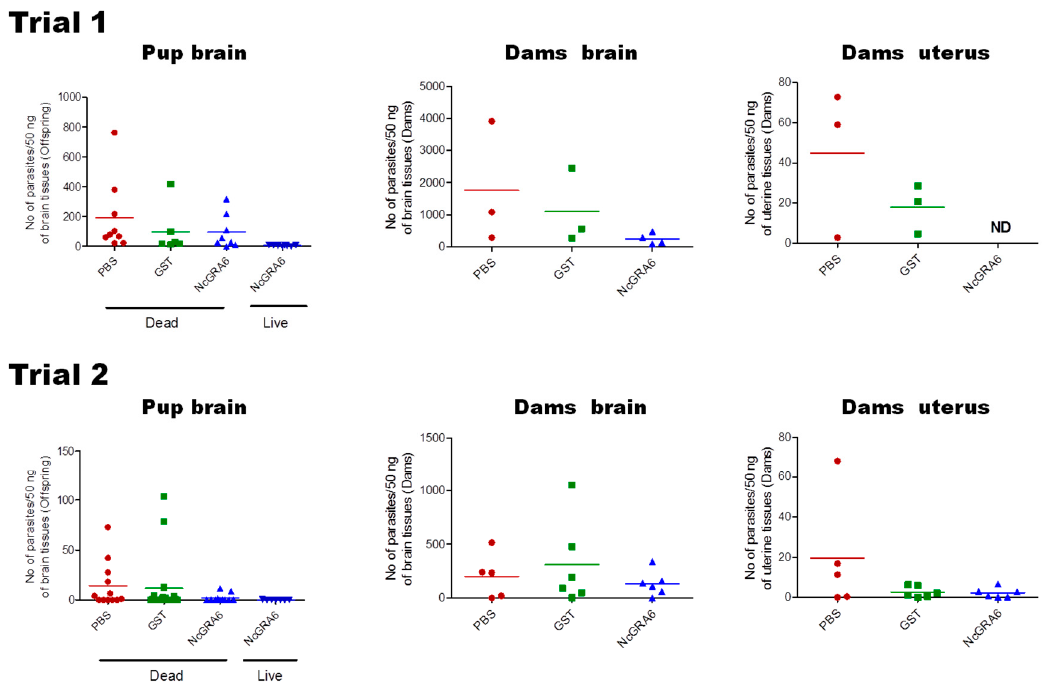
Figure 2. Parasite burden in brain of offspring and brain and uterus of dam. Parasite numbers were measured in the brains of the dead and surviving offspring at 30 days after birth. Some brains of dead offspring could not be collected because of cannibalistic behavior by dam. No statistically significant differences were observed among different groups with one-way ANOVA plus Tukey–Kramer post hoc analysis, p > 0.05. In case of dam, pregnant mice were monitored daily until 30 days after birth (40–42 dpi). The results of parasite burden in the brain were analyzed with one-way ANOVA plus a Tukey–Kramer post hoc analysis, and no significant difference was observed between different groups of dams. ND, no detectable number was observed. Horizontal solid lines with different colors represent the mean of calculated values.